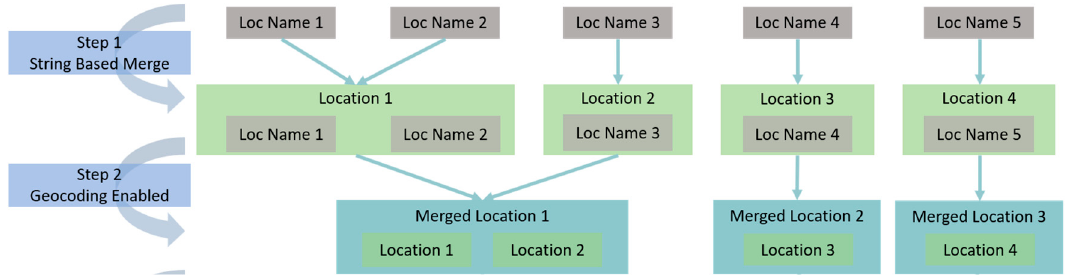
Figure 3. An example showing how extracted local gazetteer is grouped, geocoded, and merged to the final detected events.